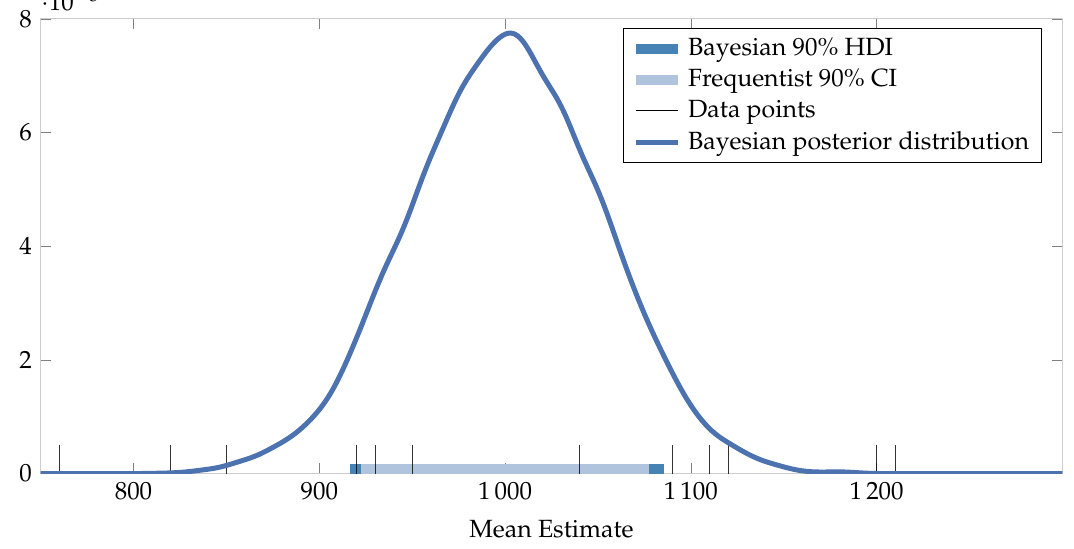
Figure 2. Illustration of Bayesian posterior density Pr ( µ | D ) , 90% Highest Density Interval (HDI), and frequentist 90% Confidence Interval